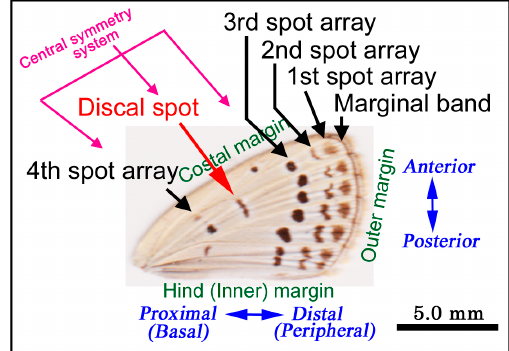
Figure 1. Nomenclature of color pattern elements and other features of the adult forewing of Z. maha . The black spot arrays are defined from the distal to proximal direction as the first, second, third and fourth spot arrays. Additionally, there are the marginal band and discal spot. The discal spot is thought to be the center of the central symmetry system that includes the third and fourth spot arrays [24,25].